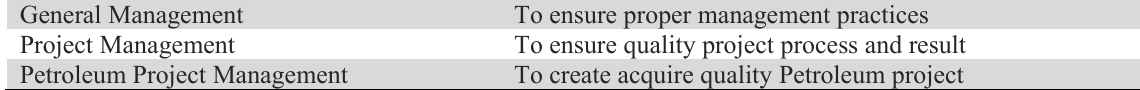
Necessity of each